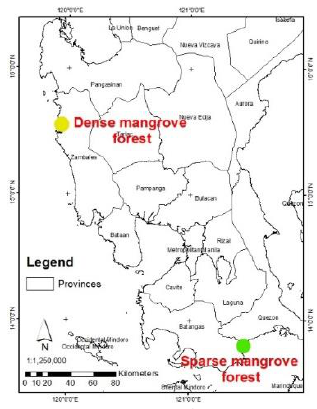
Figure 2. Location map of the two study sites